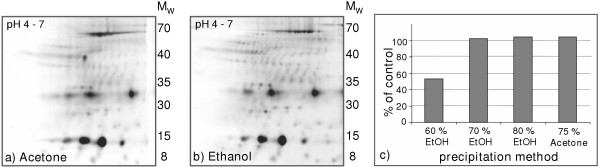
Comparison of different protein precipitation methods. a) 75% acetone precipitation and b) 70% ethanol precipitation of prefractionated SYPRO Ruby stained CSF proteins with pH 4.5–6.0, separated on IPG-strips, pH 4–7. The molecular weights (MW) are in kDa. c) The protein recovery as % of control (untreated CSF) after precipitation with indicated concentrations of ethanol and 75% acetone. The protein recovery was measured using the RC DC protein assay (Bio-Rad).